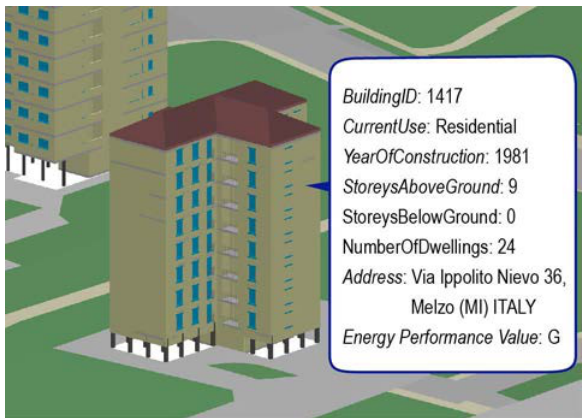
Figure 3. Geometric and semantic enrichment of building data through the integration different datasources (TDB, cadastral data, BIM data). Image by Alice Pasquinelli and Daniela